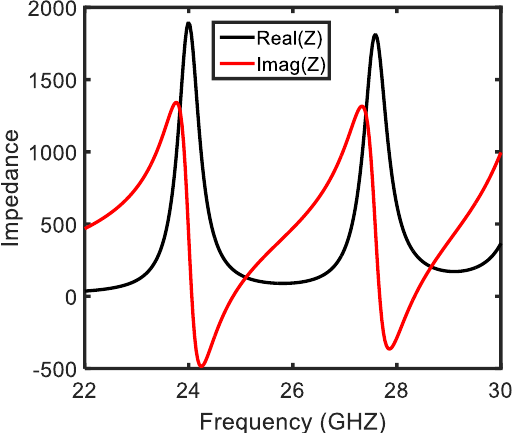
Figure 7. Effective impedance of the metamaterial absorber.